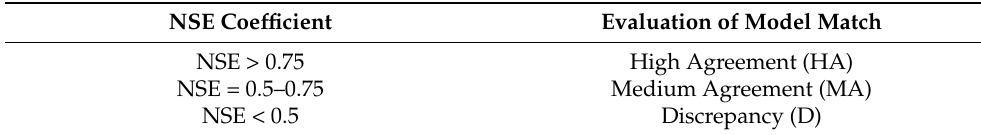
Table 3. Evaluation of Nash–Sutcliffe efficiency (NSE) coefficient